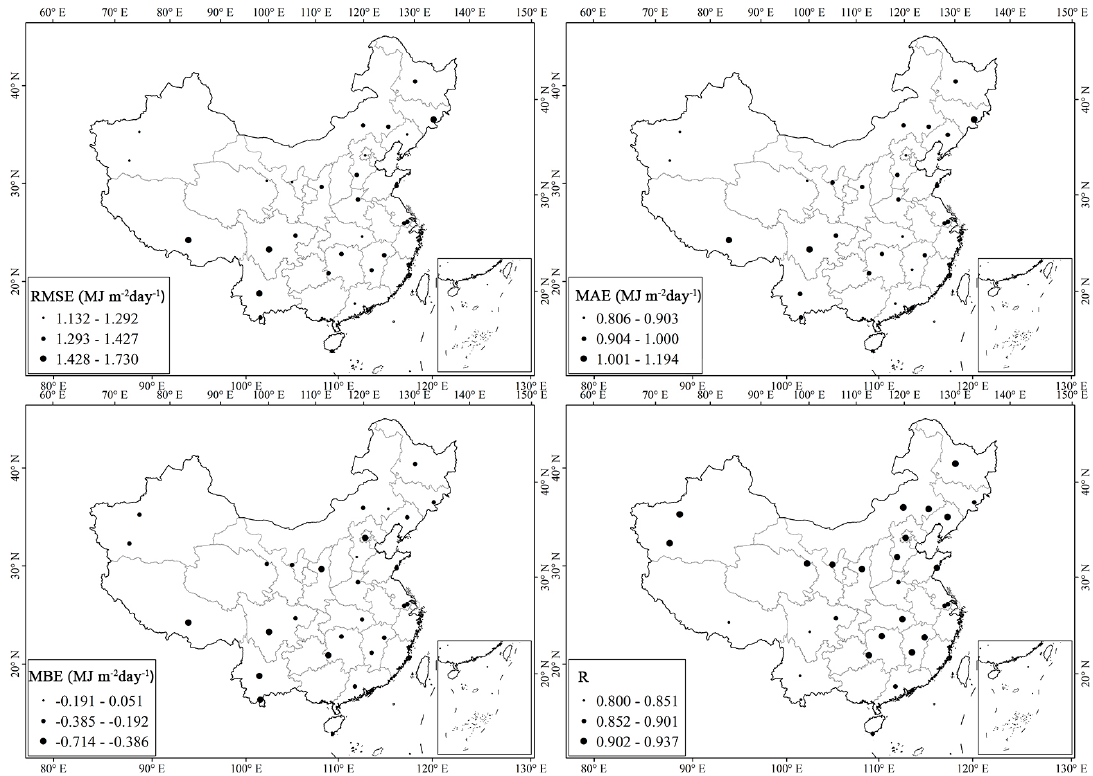
Figure 7. Spatial variations of the statistical indicators representing the model accuracy for ten PAR models.